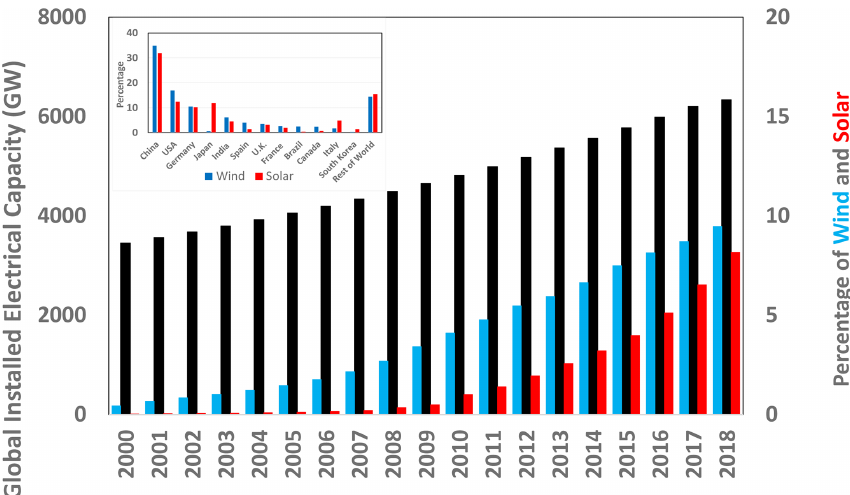
Figure 8. Global installed electrical capacity (GW) and the percentage contribution from wind power (blue bars) and solar power (red bars) from 2000 to 2018. Inset: percentage of wind and solar power by country in 2017 (IRENA, 2019).